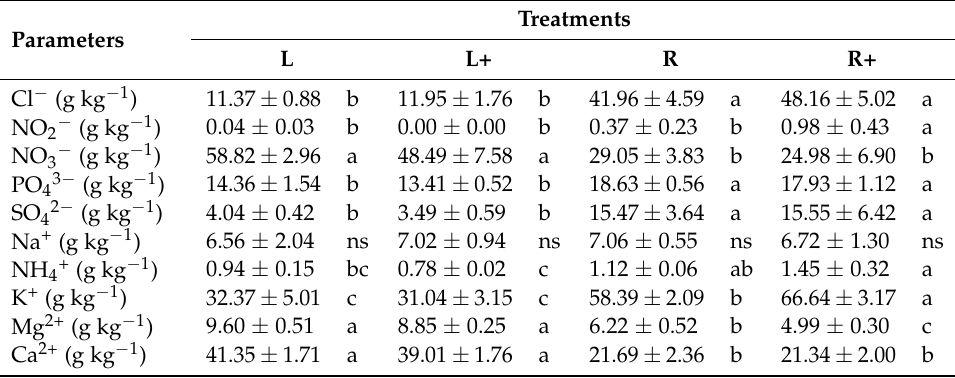
Table 6. Anion and cation contents in the dry biomasses of monocultured and intercropped lettuce and red chicory. Different letters indicate significant differences ( p < 0.05) among treatments for each parameter, according to the Tukey’s HSD test. ns = not significant